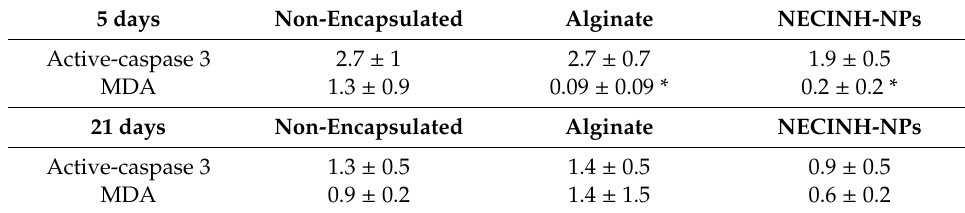
Table3. ImpactofNECINH-nanoparticles(NPs)-loadedhydrogelonapoptosis(activecaspase3-positive cells) and membrane lipid peroxidation (Malondialdehyde (MDA)-positive cells). After 5 days of transplantation, noe ff ectonapoptosiswasobserved. MDA + cellswerereducedinalginateandNECINH groups. After 21 days of transplantation, no e ff ect on apoptosis or lipid peroxidation was observed. Results are expressed as a mean number of positive cells / seminiferous tubule section ± standard deviation. * indicates p < 0.05 relative to day 5 non-encapsulated.